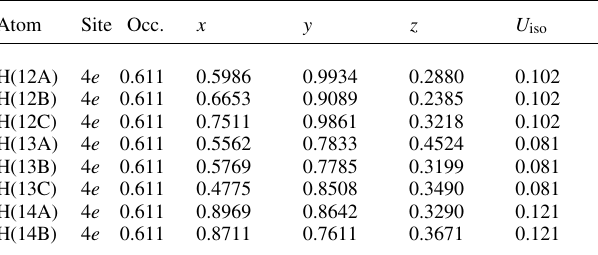
Table 2. Atomic coordinates and displacement parameters (in Å 2 ) . Atom Site Occ.